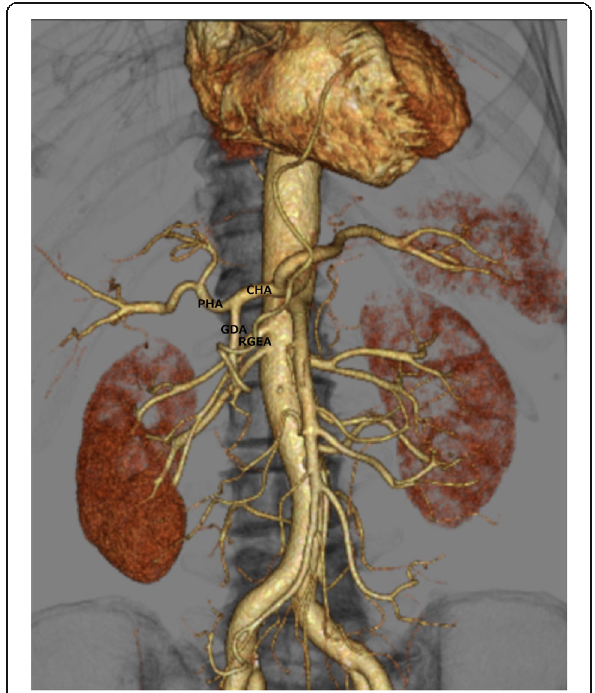
Fig. 3 3D-CTA revealed that the gastric tube was the feeding vessel to RGEA branching from GDA